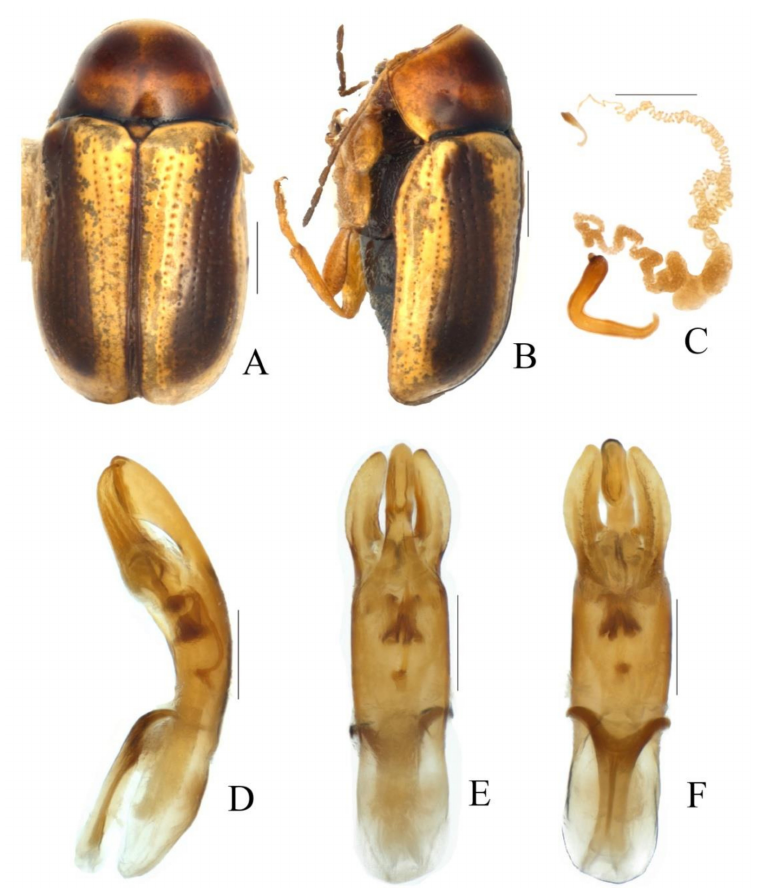
Figures 36 and 37.